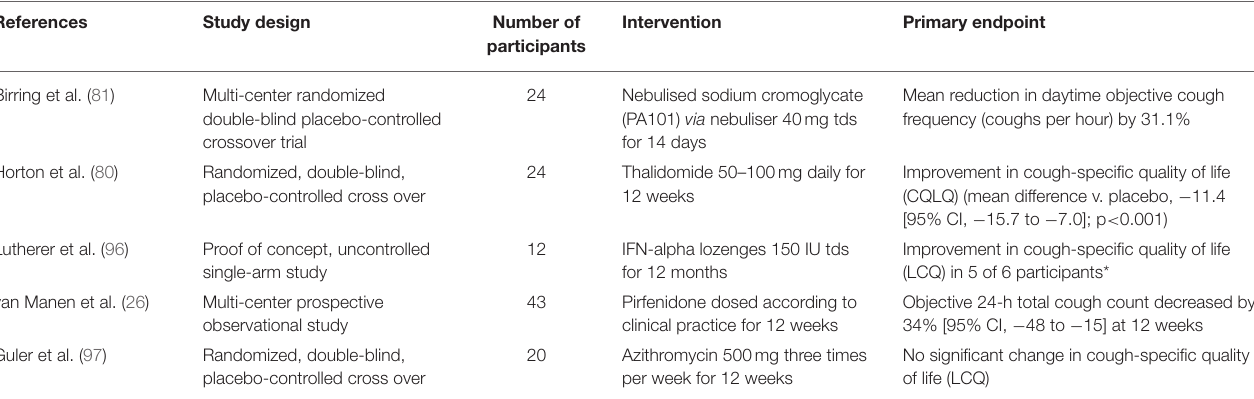
TABLE 3 | Summary of trials of pharmacological therapy in IPF-related